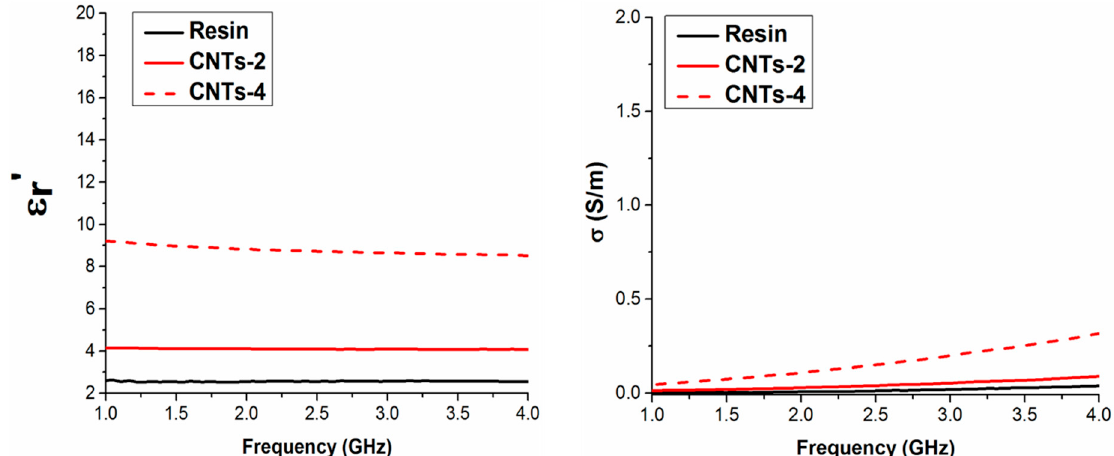
Figure 9. Real part of permittivity ( left panel ) and conductivity ( right panel ) in the microwave range for pure epoxy and epoxy composites filled with 2 and 4 wt % of MWCNTs.